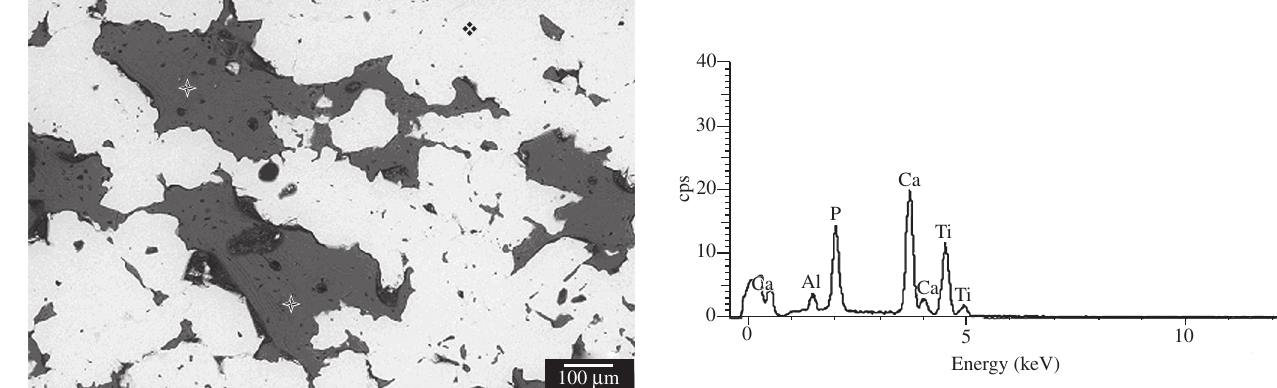
Figure 9. EDS analysis showing main elements of bone-sample